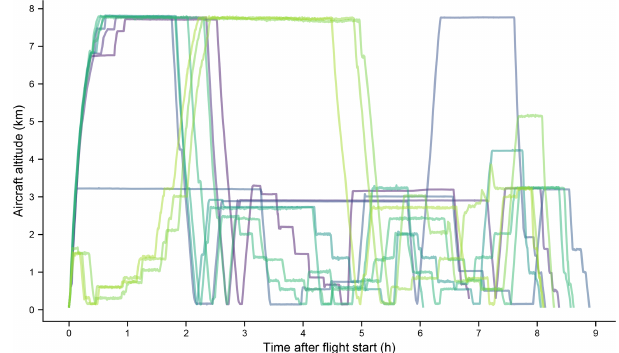
Figure 2. Flight altitude as a function of time after takeoff for the 11 flights by the NOAA P-3 aircraft during ATOMIC, using the same colors as Fig. 1. Sondes were dropped from ∼ 7 . 5km, with each circle taking roughly an hour; transits were frequently performed at this level to conserve fuel. Long intervals near 3km were used to deploy AXBTs and/or characterize the ocean surface with re- mote sensing. Stepped legs indicate times devoted to in situ cloud sampling. On most flights the aircraft climbed quickly to roughly 7.5km, partly to deconflict with other aircraft participating in the experiment. On the three night flights, however, no other aircraft were operating at takeoff times and cloud sampling was performed first, nearer Barbados than on other flights.